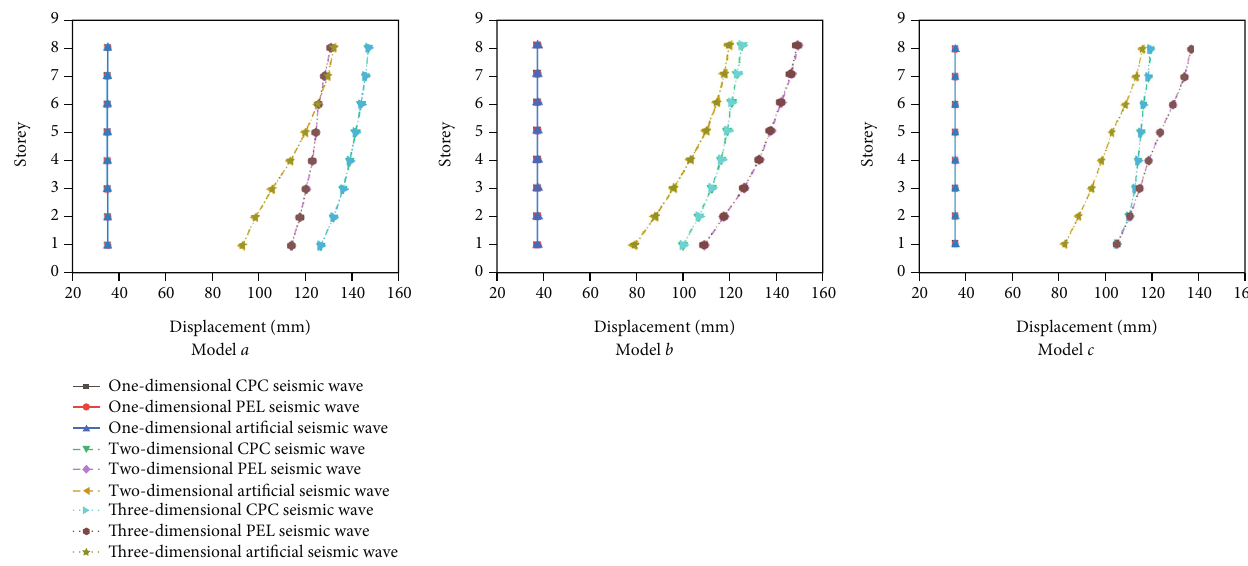
Figure 11: Comparison of fl oor displacements of di ff erent models in Y